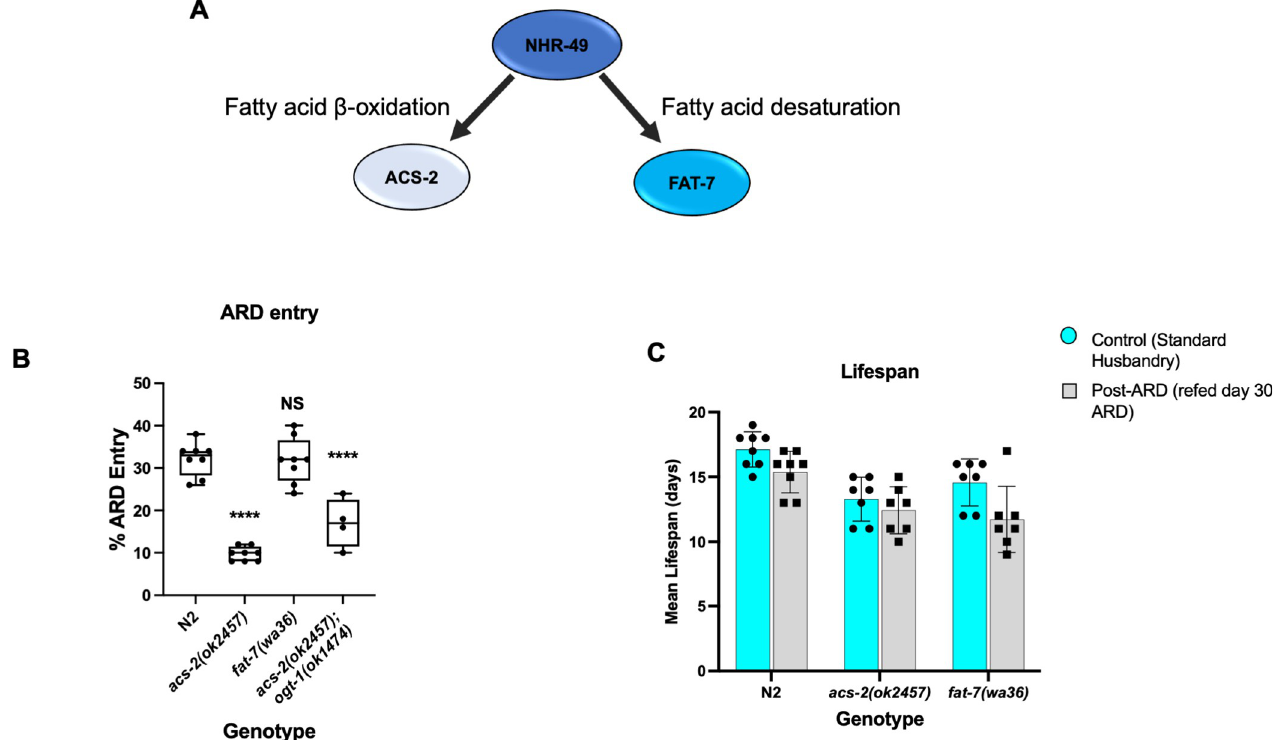
Fig 4. Fatty acid beta-oxidation, but not desaturation, plays a role in ARD entry. (A) NHR-49 regulates both fatty acid beta-oxidation (ACS-2) and desaturation (FAT-7) via genetically separable pathways that are known to generate distinct phenotypic outputs. (B) ARD entry was significantly impaired with acs-2(ok2457) but not with the fat-7(wa86) mutant. The double mutant acs-1(ok2457); ogt-1(ok1474) was also significantly impaired for ARD entry. P- value ���� = < 0.0001 in comparison with N2 as determined using one-way ANOVA, NS = not significant. (C) Lifespan under standard conditions and with refeeding at day 30 of ARD was not significantly altered in these mutants as determined by one-way ANOVA. Error bars represent standard deviation.